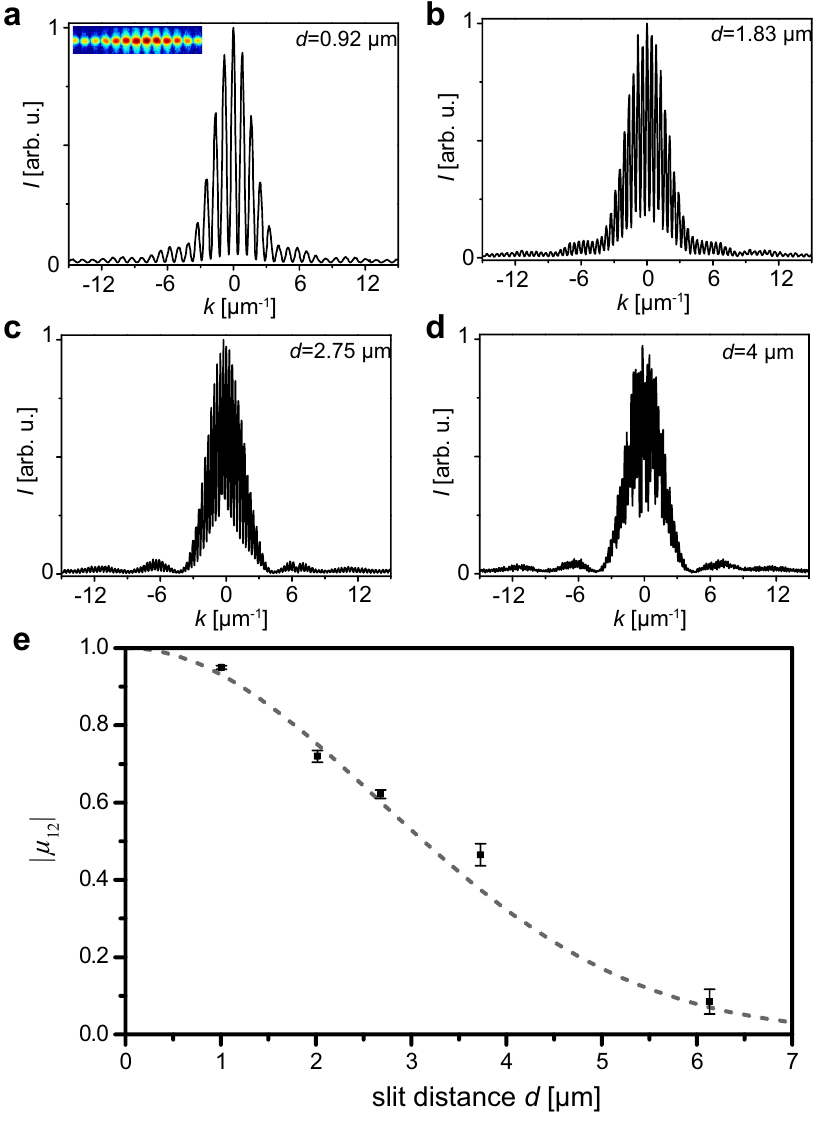
Figure 2. Recorded fringe patterns after a double slit in the refocused beam. Panels (a–d) show characteristic fringe patterns measured for different slit distances d as indicated in the panels. The inset in panel (a) shows an example of the raw data captured on the CCD featuring well resolved fringes. ( e ) Modulus of the complex coherence factor | µ 12 | for different slit distances along the horizontal axis of the laser. The dotted line shows a Gaussian fit with a width at full width half maximum of 3.13 µ